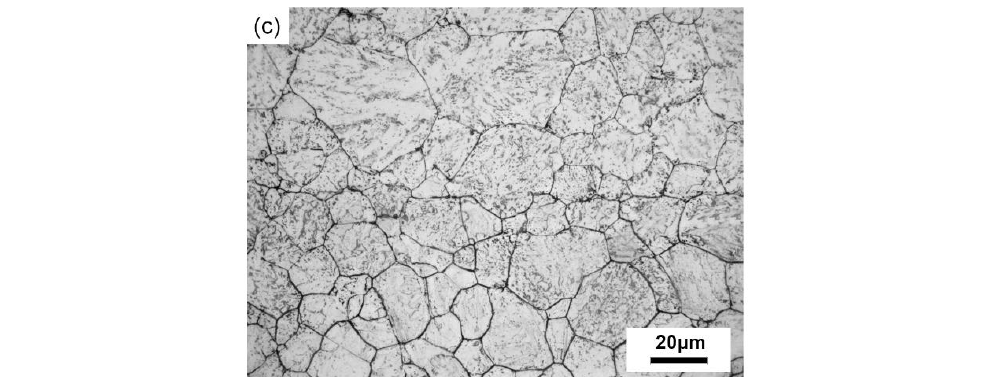
Figure 7. The microstructure of the SA 508–3 after compression at 950 °C with different reduction ratios: ( a ) 10%, ( b ) 20%, and ( c ) 30%.